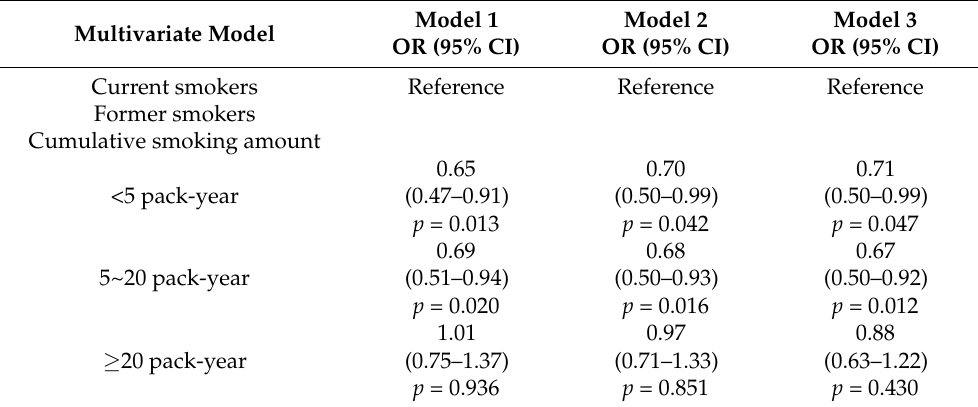
Table 3. Unadjusted and adjusted odds ratios and 95% confidence intervals for the elevated serum hs-CRP level * according to cumulative smoking amount in Korean